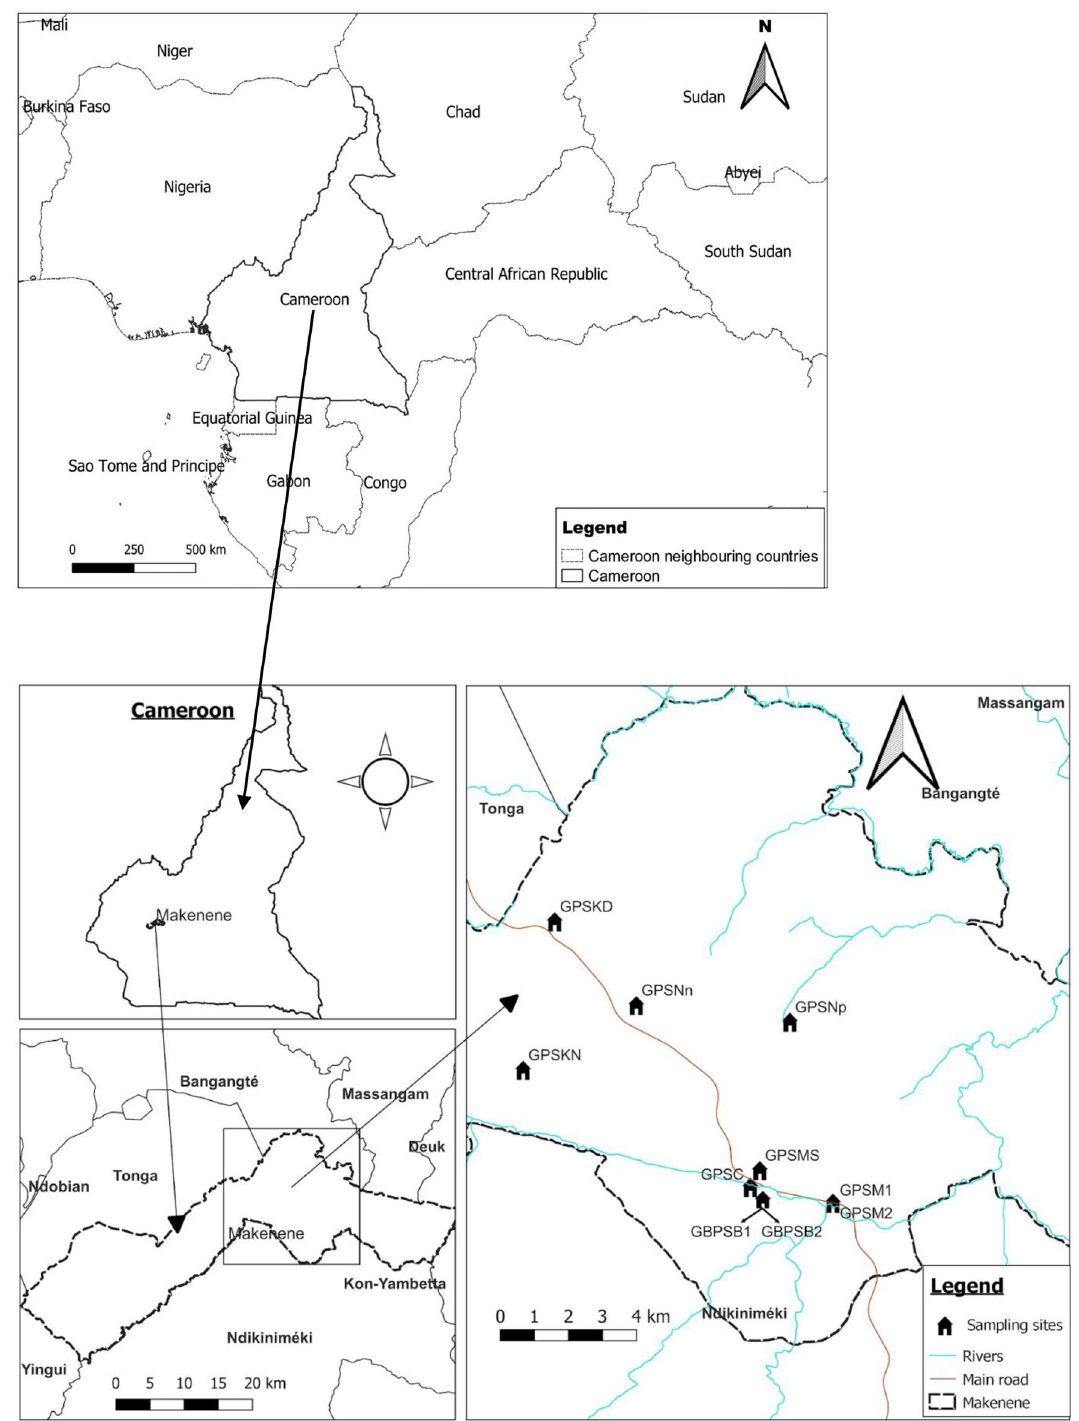
Figure 1. Map of Makenene showing schools where children were sampled (map obtained from: https:// qgis. org/ downl oads/ QGIS- OSGeo 4W-3. 16. 10-1- Setup- x86_ 64. exe with layers downloaded using the link: https:// www. diva- gis. org/ gdata; consulted, 14/09/2021). GBPSB1: Government Bilingual Primary School of Baloua Group 1; GBPSB2: Government Bilingual Primary School of Baloua Group 2; GPSM1: